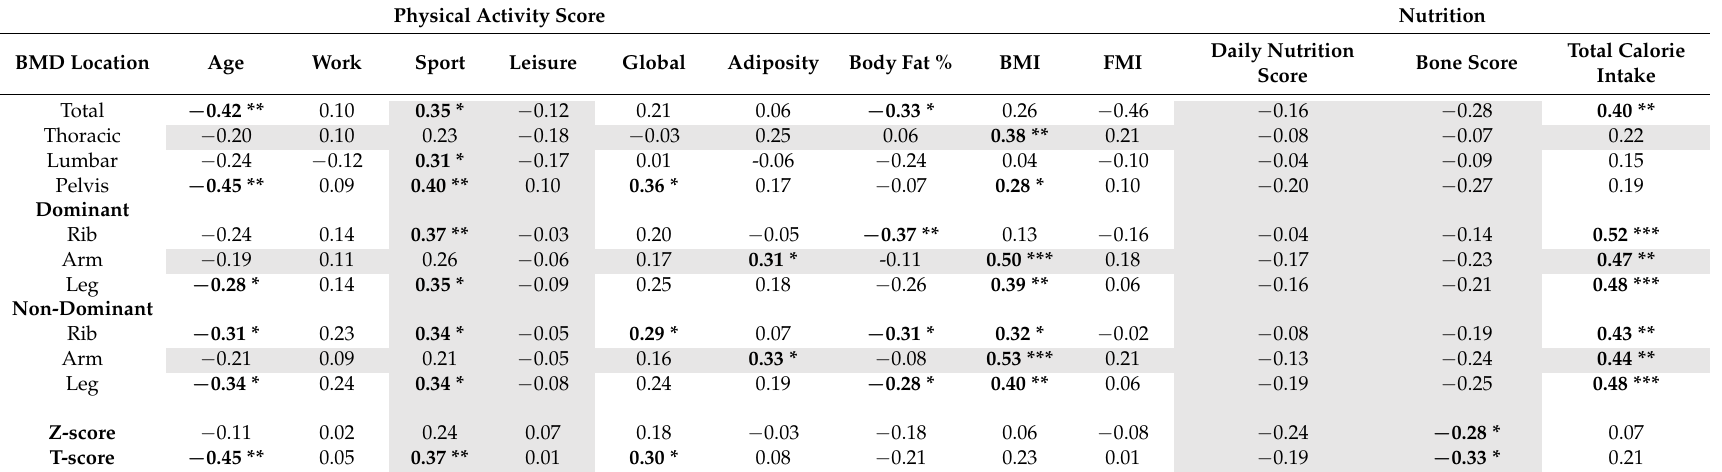
Table 3. Bivariate correlations between habitual lifestyle factors against bone mineral density (BMD) characteristics in designated body locations in 50 43–80-year-old